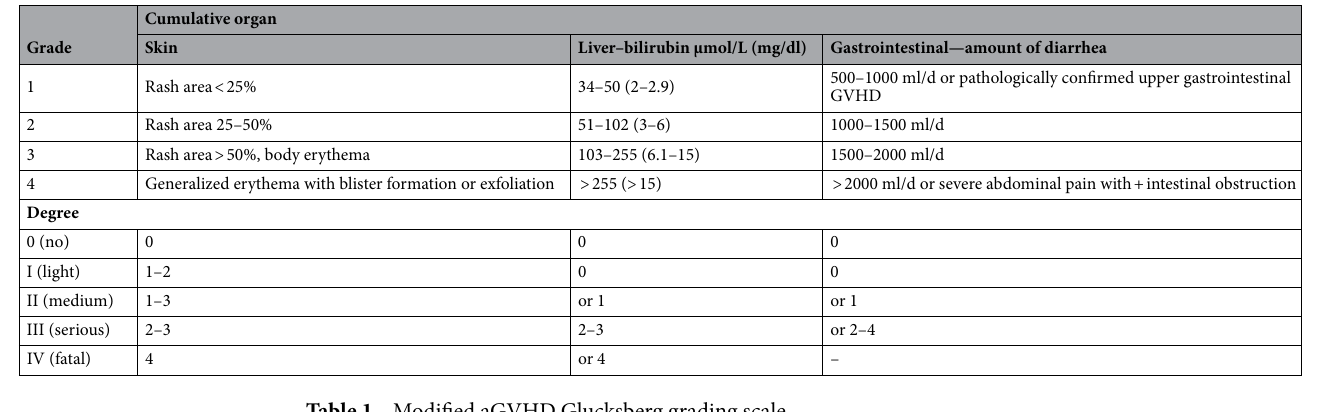
Table 1. Modified aGVHD Glucksberg grading